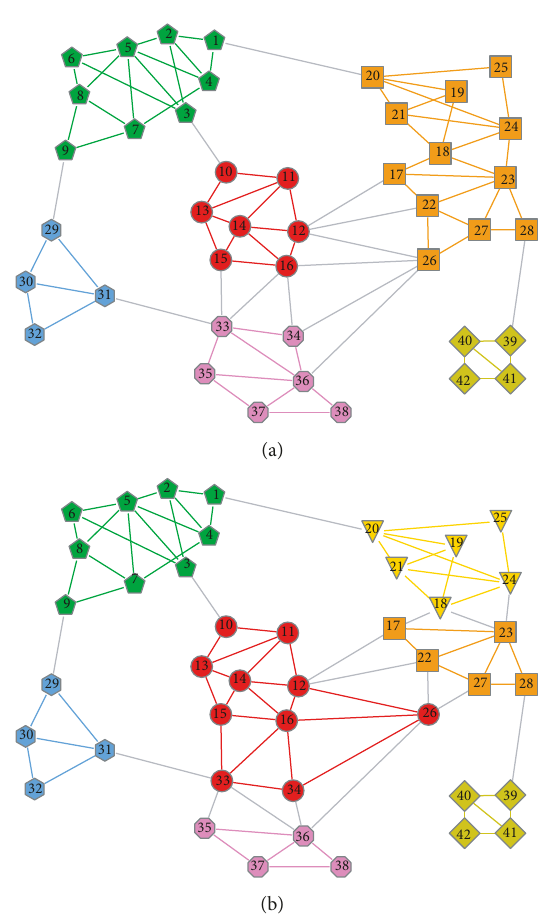
Figure 6: Risk map network . (a) The ground-truth community structure. (b) The community structure uncovered by our proposed method,